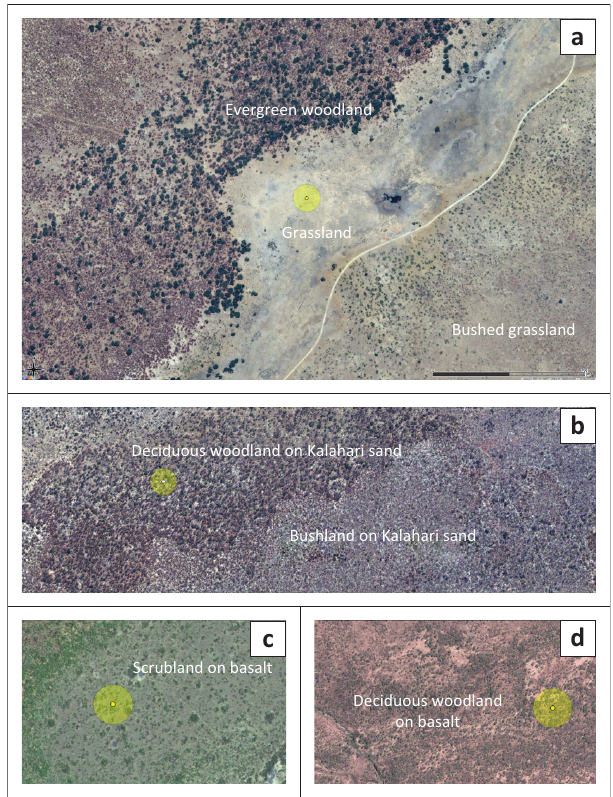
FIGURE 4: Examples of high-resolution Quickbird images used for creating validation samples. Yellow circles indicate 120 m-buffers around locations of validation points (images shown vary in scale, hence variation in apparent buffer size).